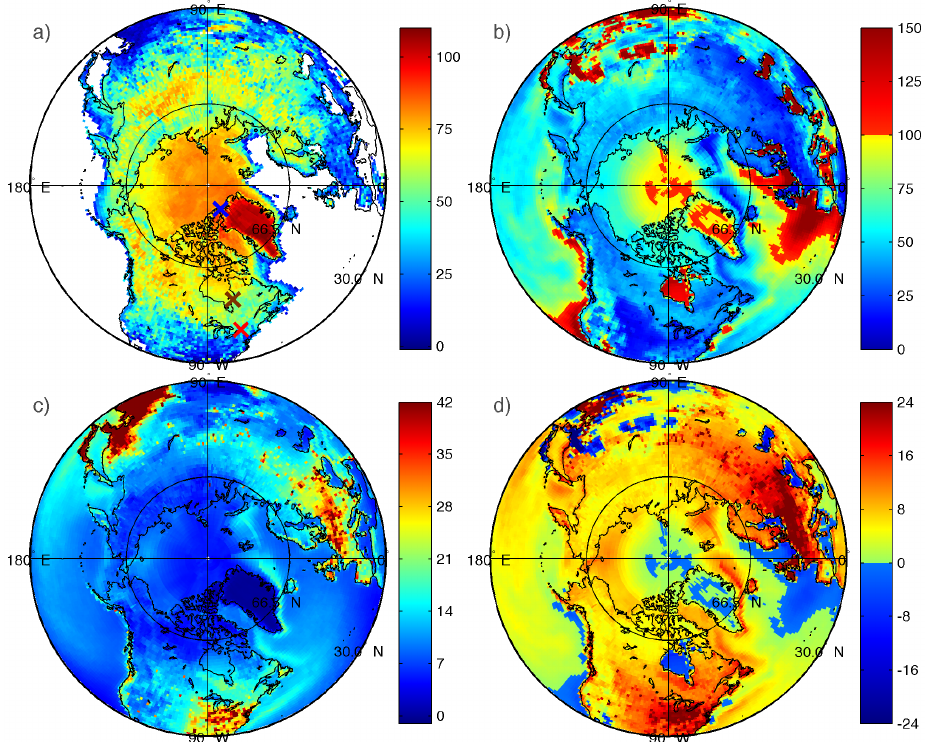
Fig. 7. Presented are annual averages based on 5yr (2005–2009) of data from SORun of (a) the fraction (%) of mercury deposited onto snowpacks that is revolatilized. The blue, brown and red crosses indicate the location of Alert, Kuujjuarapik and Point Petre, respectively; (b) total mercury emission from the surface as a fraction (%) of gross mercury deposition; (c) net mercury deposition (µgm − 2 yr − 1 ); and (d) net mercury accumulation (µgm − 2 yr − 1